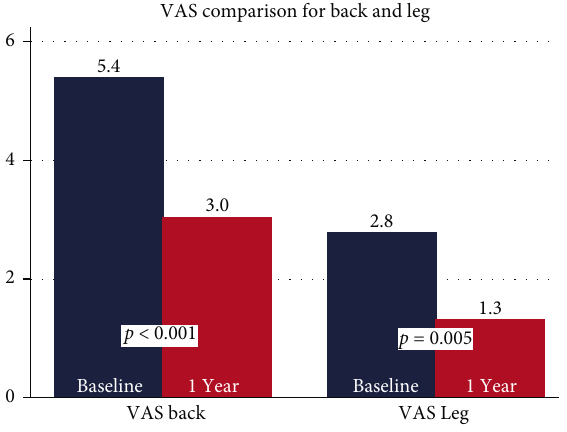
Figure 2: Bar graph comparing mean VAS scores at baseline and 1 year: back (left) and leg (right).